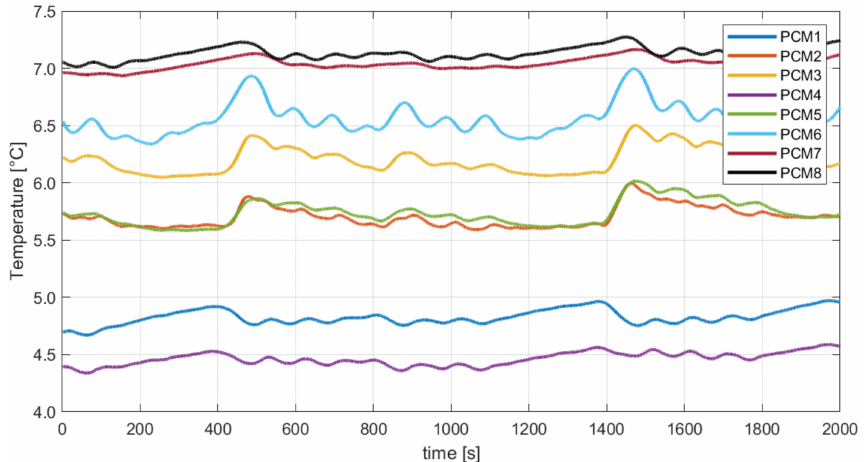
Figure 7. Temperatures in the PCM for a test with parallel charge/discharge (cooling mode 4) of the